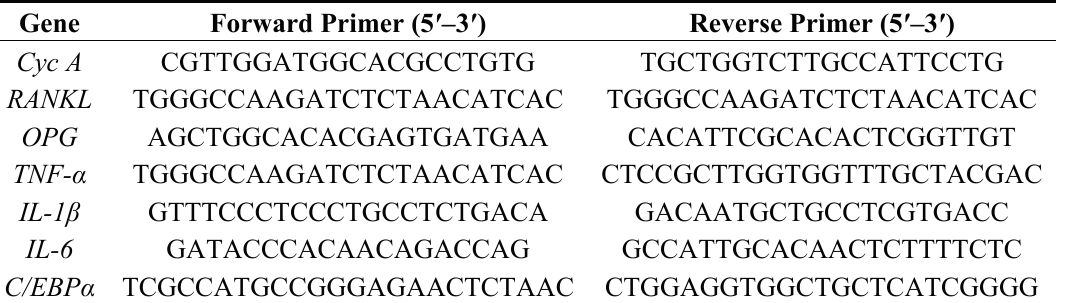
Table 1. Forward and reverse primer sequences used for mRNA expression